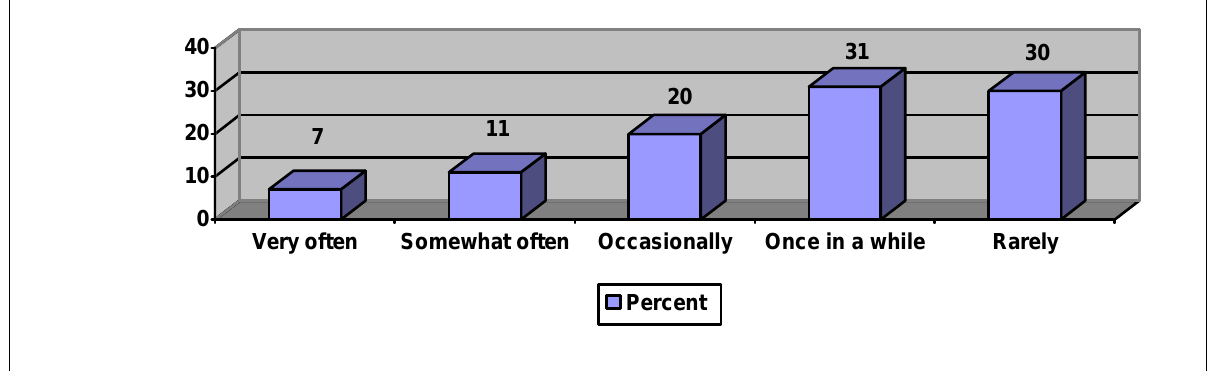
Percent of respondents who thought about